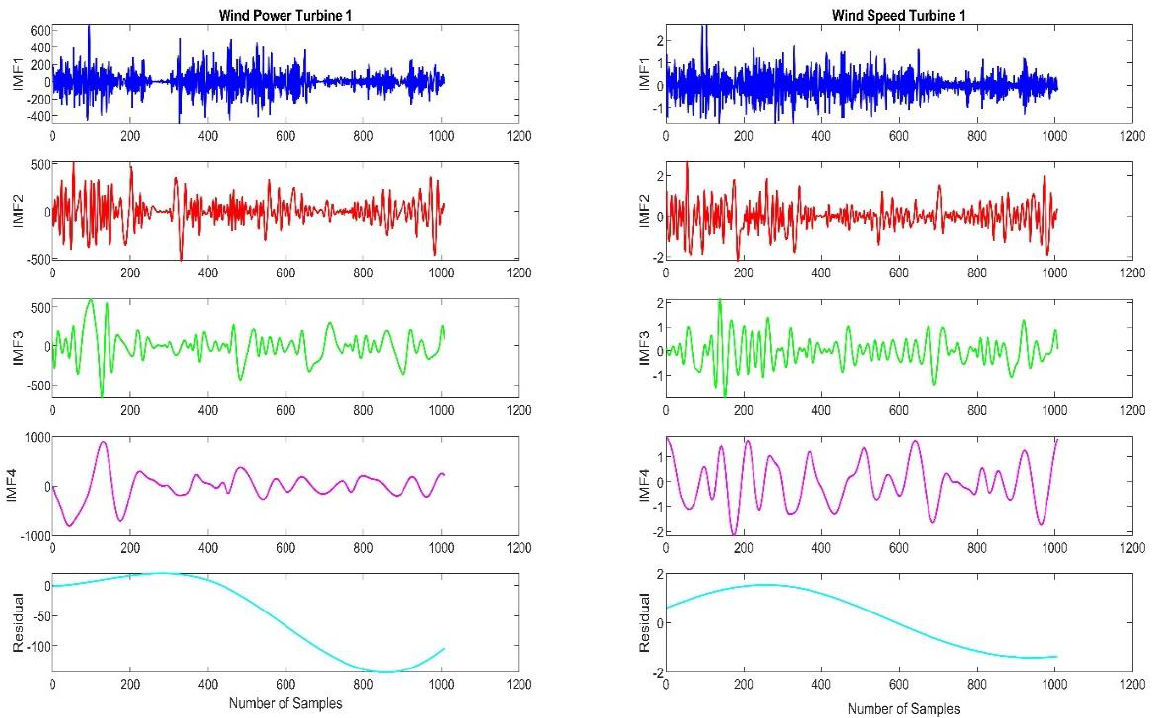
Figure 2. The EMD output, i.e., decomposition signals of wind power and wind speed of turbine 1 (WT1). Five types of decomposed frequencies (IMF1, IMF2, IMF3, IMF4, residual) are